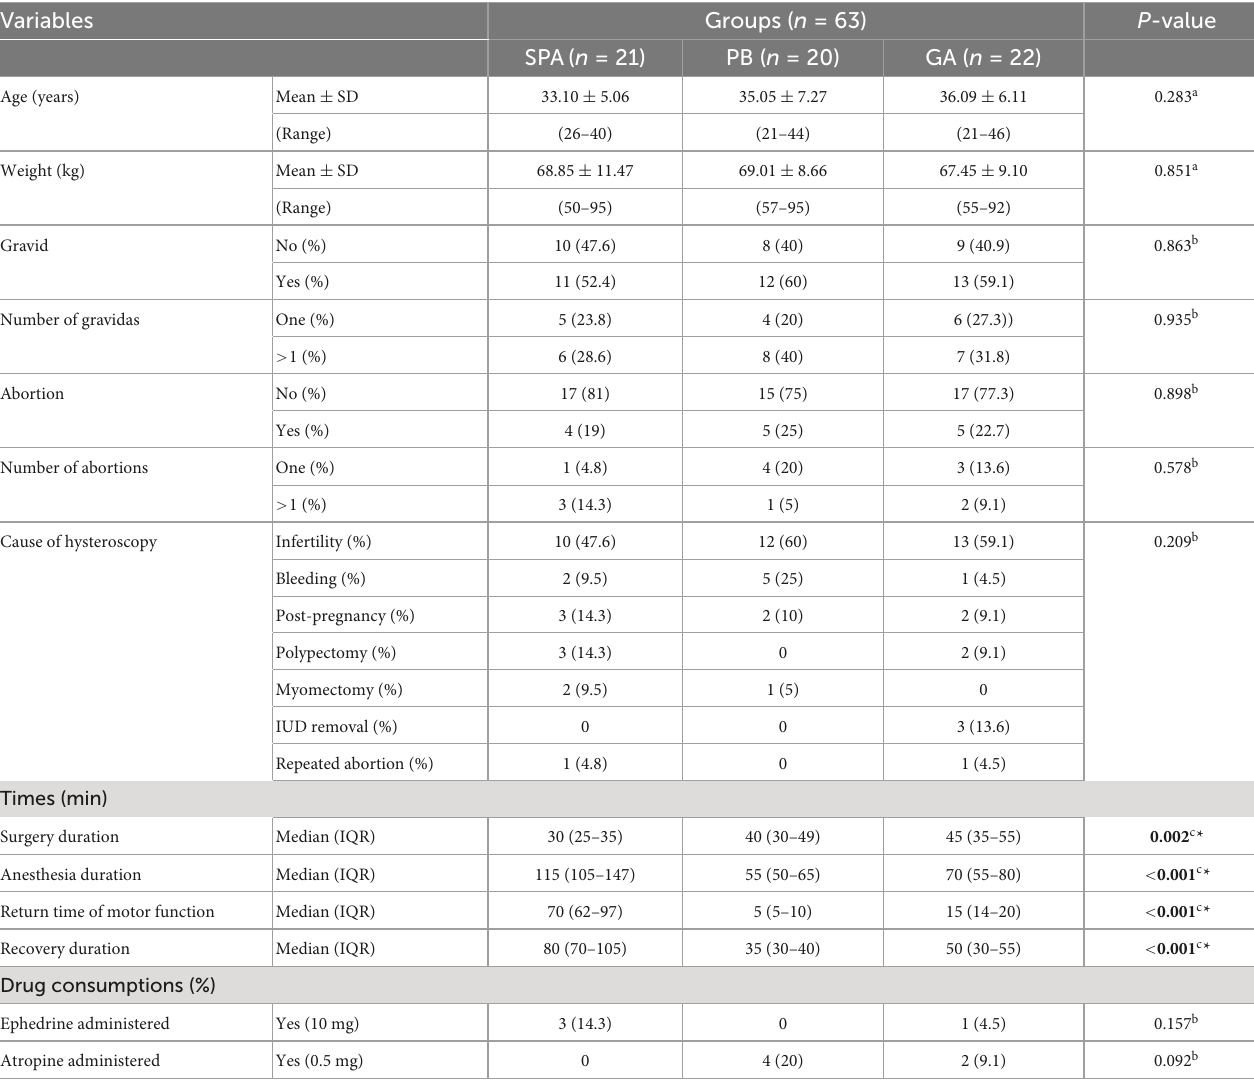
TABLE 1 Comparison of demographic and clinical characteristics between three groups of study.